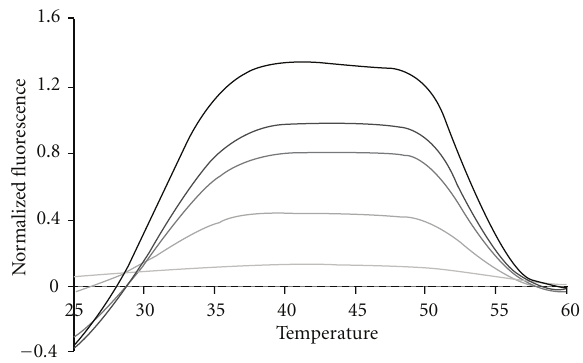
Figure 8: The fluorescent contour of a SE dilution series from 10 5 genome copies down to 10 genome copies as shown by the gradient from dark (10 5 ) to light (10). The subtracted NTC background is shown by the dashed line to emphasize that the 10 copy dilution is above background. Figure 9: The fluorescent contours of mixtures of K. pneumoniae and S. epidermidis in the Quasar channel.